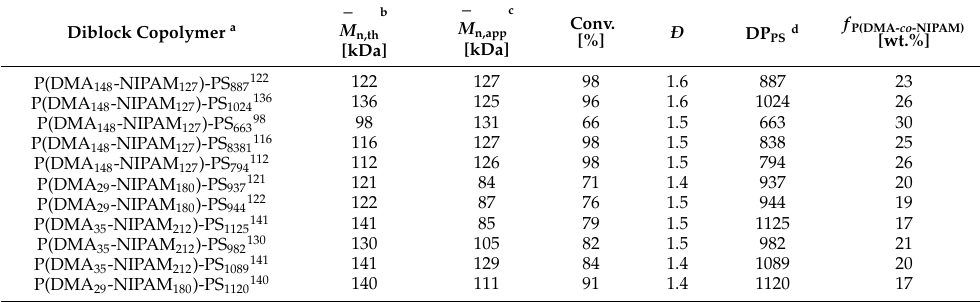
Table 2. Molecular characteristics of the synthesized P(DMA- co -NIPAM)- b -PS diblock copolymers, listing the respective weight fraction of the PS block. Diblock Copolymer a